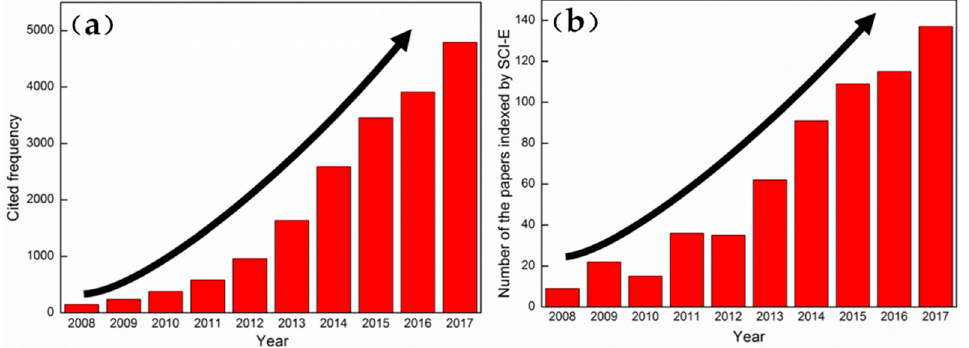
Figure 1. ( a ) The change in the number of papers indexed by SCI-E in 2008–2017; ( b ) The change in the number of cited frequency of those indexed papers from 2008–2017.